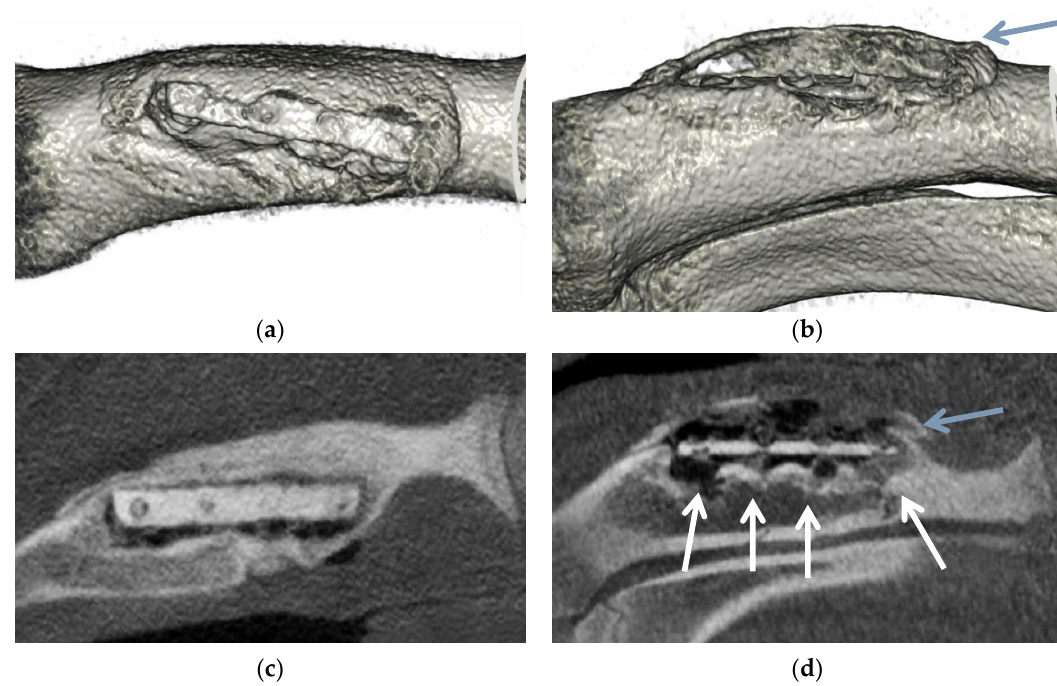
Figure 15. Micro-CT images recorded 6 months after surgery: ( a ) 3D reconstruction top view, ( b ) 3D reconstruction side view, ( c ) Micro-CT top view, and ( d ) Micro-CT side